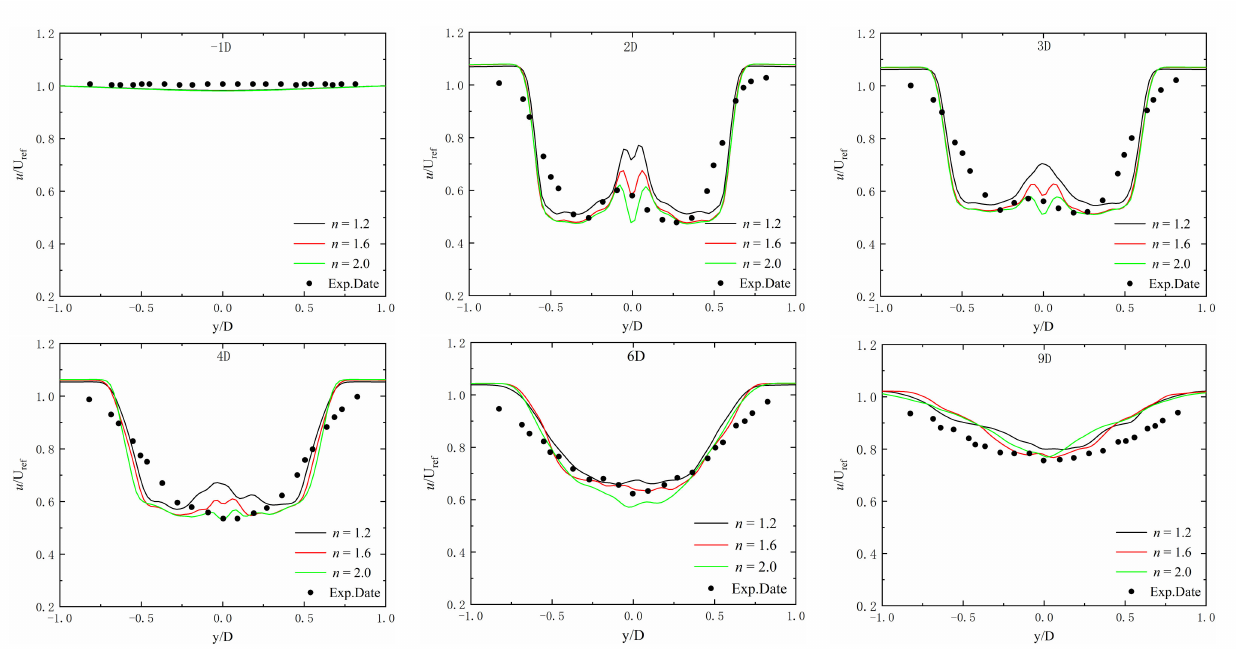
Figure 5. Average radial distribution velocity profiles in different locations under different smoothing parameters. The black points represent the experimental data [33] (U ref = 5 m/s). Reprint with permission 5219051009765; Copyright 2018, Elsevier.